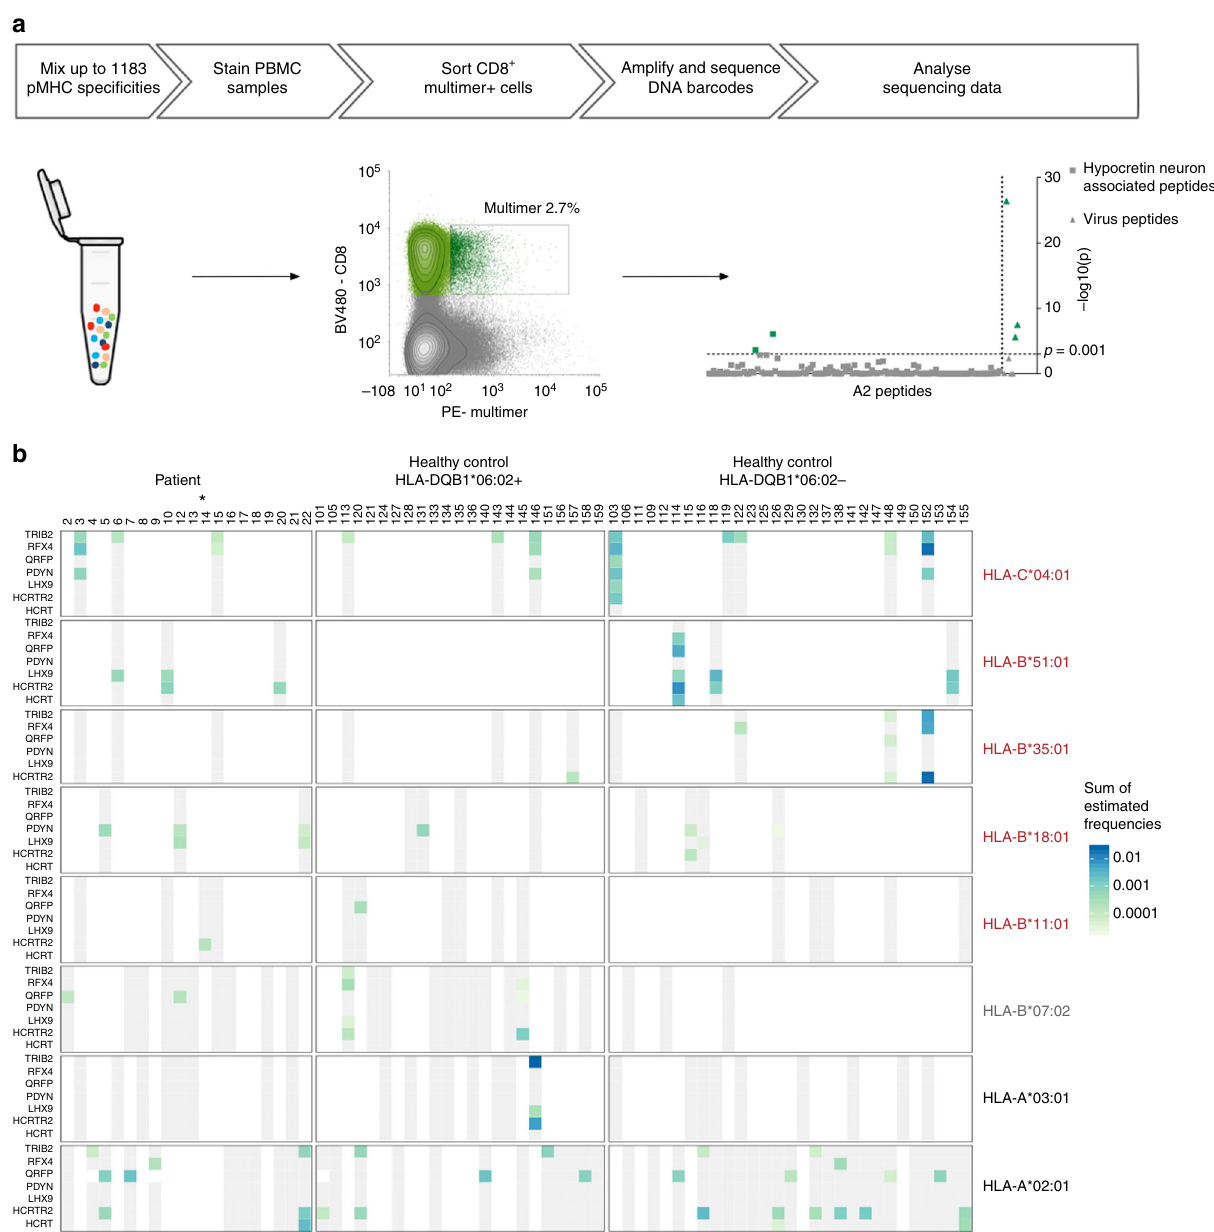
Fig. 2 Overview of the experiment pipeline and T-cell screening. a Overview of the experiment pipeline. MHC multimers are mixed and used to stain patient and healthy control PBMC samples. CD8 + , multimer-binding T cells are sorted and associated DNA barcodes are ampli fi ed, sequenced, and analyzed. This process is depicted with a sort plot from donor 138 and the CD8 + T-cell recognition detected in the given sample. Recognition is de fi ned based on the log 2 fold change of the number of reads compared with triplicate baseline samples with p < 0.001 (egdeR). The axis is transformed to – log 10 ( p ) for visualization. – log 10 (0.001) = 3 (dotted line). b Overview of proteins and HLA types included in the screen. Each column represents one donor. Donors are grouped in three cohorts: NT1 patients and HLA-DQB1:06.02-positive and negative healthy controls. Rows show the seven proteins for each of the eight different HLA types. Blue – green color grading determines the detection of CD8 + T-cell populations speci fi c for one or more peptides from the protein in the speci fi c HLA context, at levels according to scale. The estimated frequency represents the sum of frequencies for all NT1-related CD8 + T-cell populations, in each donor. Gray color coding indicates that the donor carries the given HLA type and was screened for recognition of the given protein in the speci fi c HLA context, but no recognition was detected. White color coding indicates that the donor does not carry the given HLA type and was consequently not screened with peptides in that HLA context. Star denotes the one patient that was HLA-DQB1*06:02 negative. NT1-associated, protective, and neutral HLA types are indicated in red, gray, and black, respectively. pMHC: Peptide-MHC complex. PE: phycoerythrin. BV480: Brilliant Violet